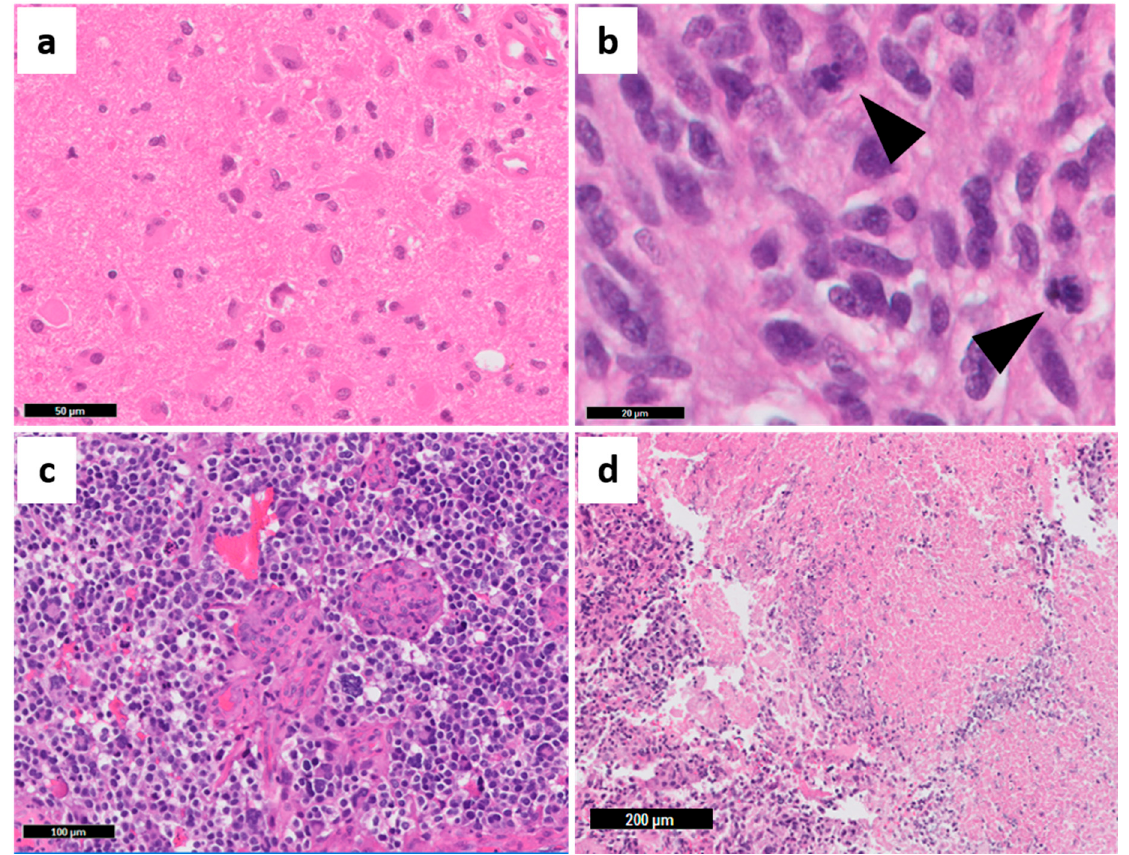
Figure 3. Saint Anne-Mayo histopathological criteria for astrocytoma grading. ( a ) Nuclear atypia in grade II—diffuse astrocytoma; ( b ) High mitotic activity (arrowheads) in grade III—anaplastic astrocytoma; ( c ) microvascular proliferation and ( d ) necrosis in GBM “multiforme”. Grade I gliomas are not part of this classification. Representative images captured from The Ohio State University (OSU) Tissue